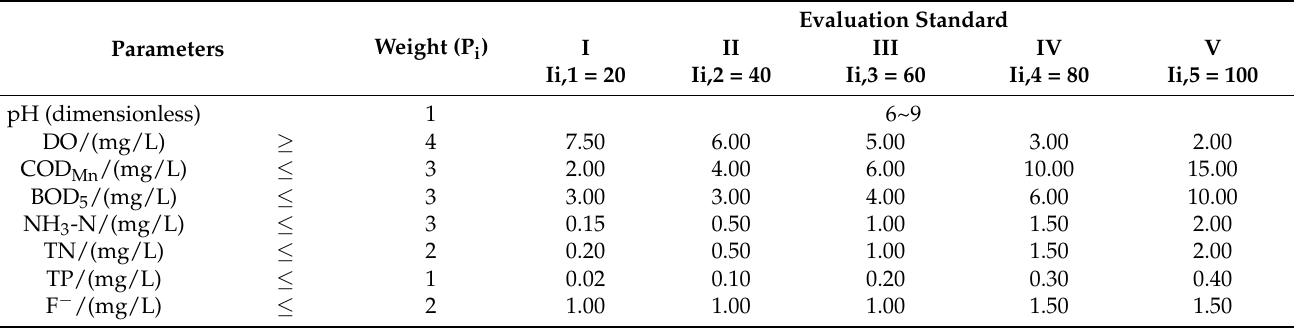
Table 1. Monitoring variables are used to calculate the water quality index and their normalization scores and relative weights.